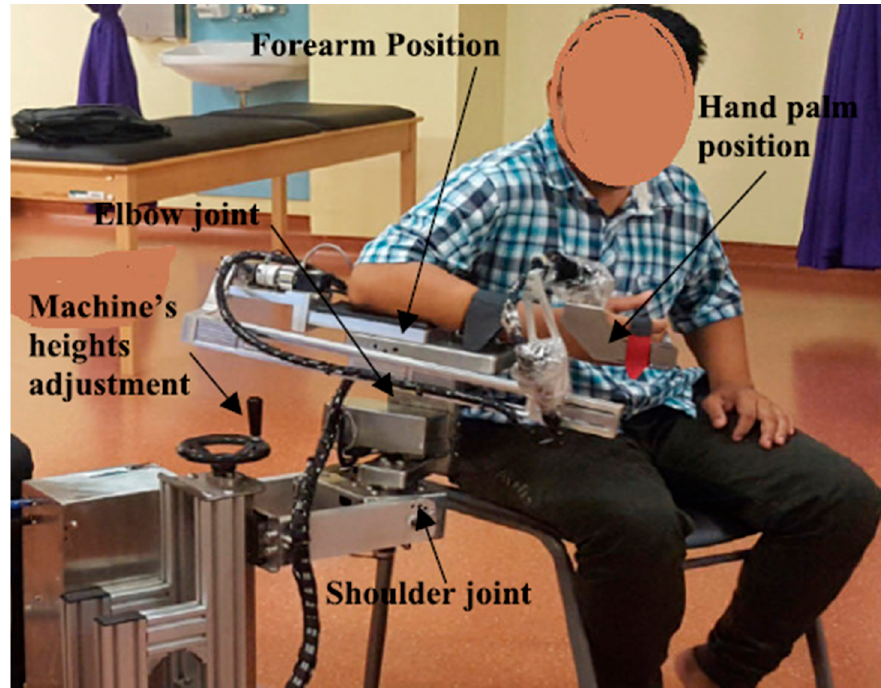
Figure 1 . The upper limb exoskeleton prototype [38]. Figure 1. The upper limb exoskeleton prototype